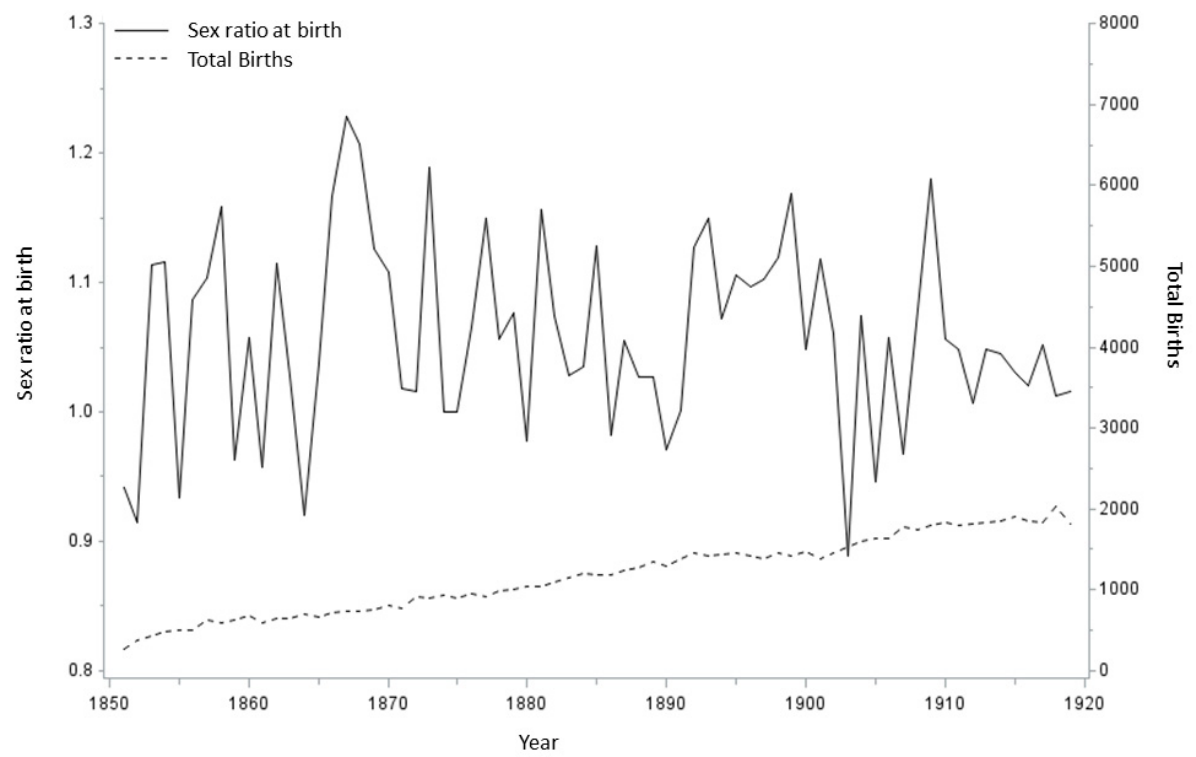
Figure 2. Sex ratio at birth and total births for Salt Lake County 1851–1919 .